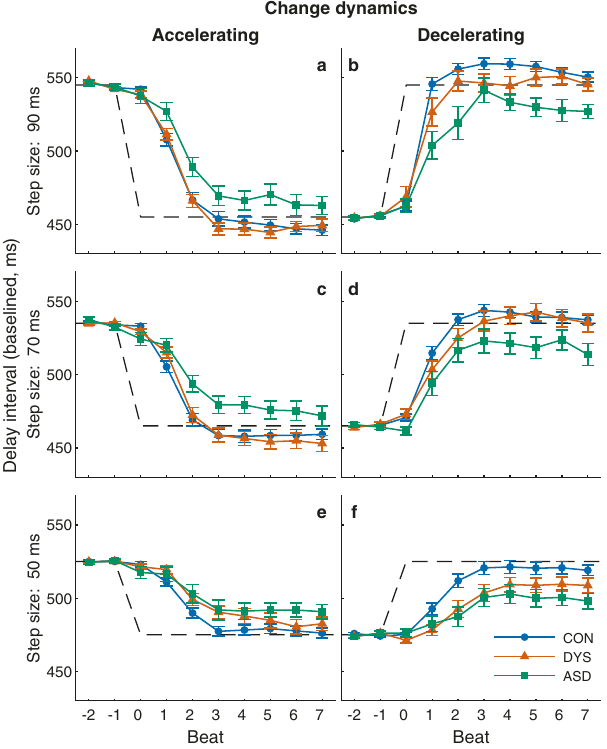
Fig. 4 Individuals with autism adapt to changes in tempo only partially, even when changes are very salient. a , b 90 ms step-size, c , d 70 ms step- size, and e , f 50 ms step-size. In each panel, the x-axis represents the metronome-beat number around the moment of tempo change (beat 0), and the y-axis measures the delay interval in each beat aligned to the pre- change metronome (mean group values, ±SEM; values were calculated by fi rst averaging responses within each participant and then across the group; error bars denote SEM across participants). The dashed lines represent the metronome beat. Changes are quickly corrected, particularly for the larger steps (panels a – d ). Reduced updates are seen for the smaller 50 ms step changes (panels e , f ), where neurotypicals (CON control) take three – four steps to correct, and individuals with dyslexia (DYS) take longer, perhaps since these steps are less salient. The dif fi culties of individuals with autism (ASD) are seen in all step changes (including the smallest step-size, panels